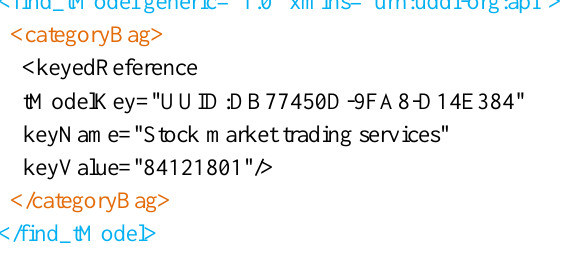
Figure 4 . Sample find_tModel